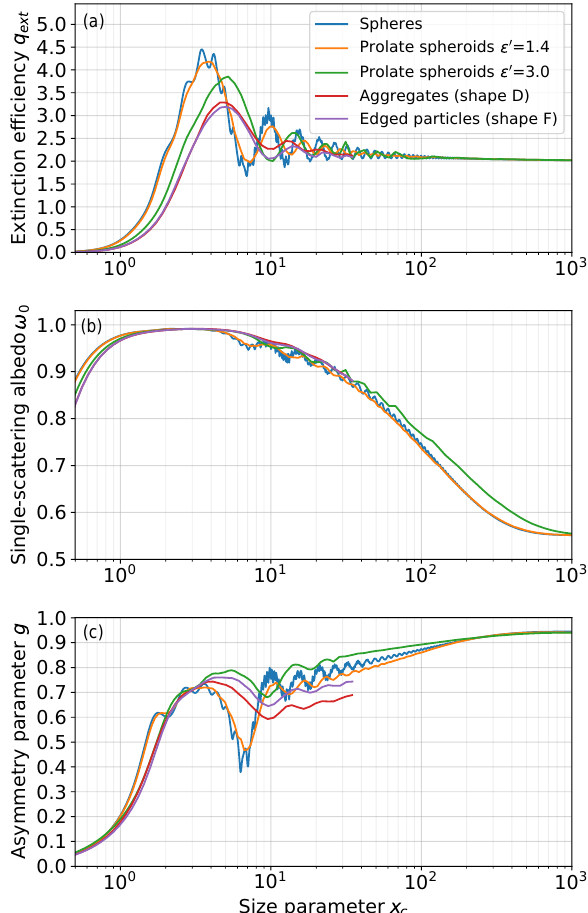
Figure 2. Optical properties of single particles (or narrow size bins in the case of spheres) with fixed refractive index m = 1 . 56 + 0 . 00215 i as a function of size parameter. The different colors denote different particle shapes. Panel (a) shows the extinction efficiency q ext , panel (b) the single-scattering albedo ω 0 , and panel (c) the asymmetry parameter g